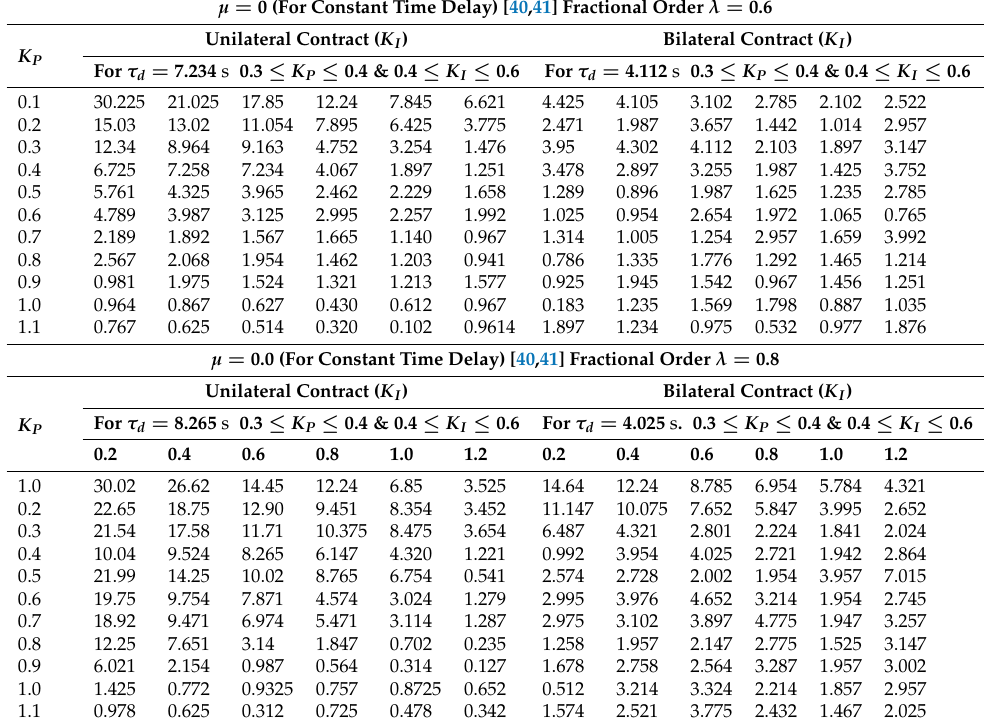
Table 5. Delay margin for FOPI controller for λ = 0.6 and